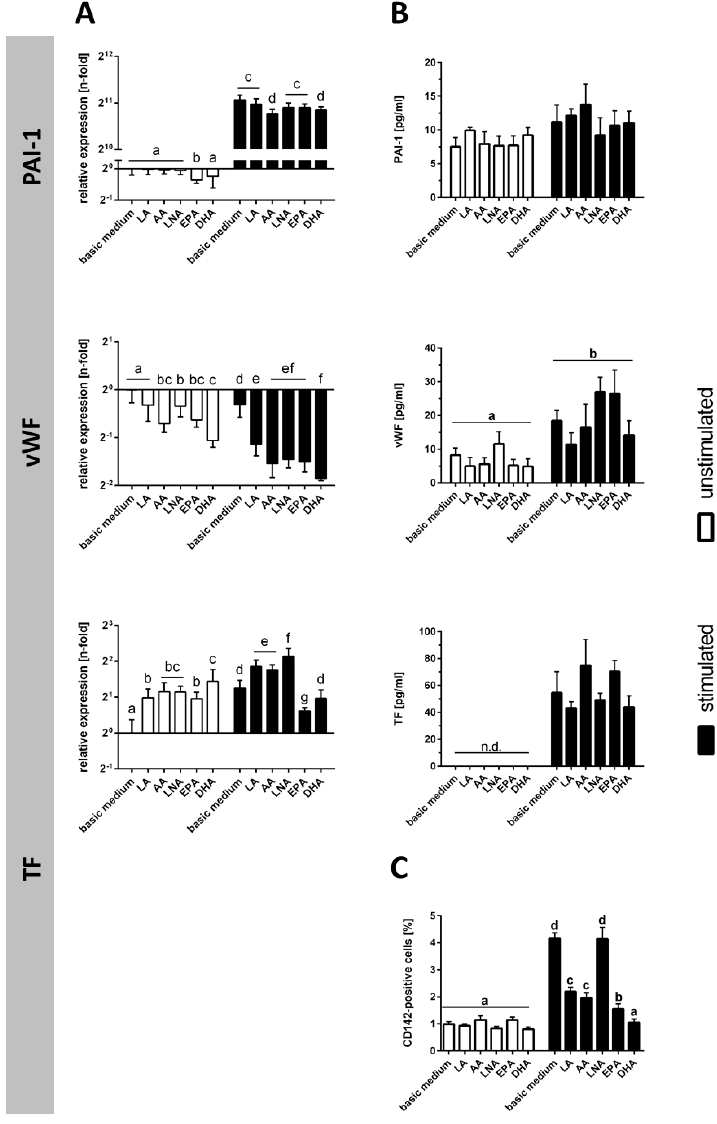
Figure 4. Expression of coagulation factors subject to stimulation and PUFA supplementation.